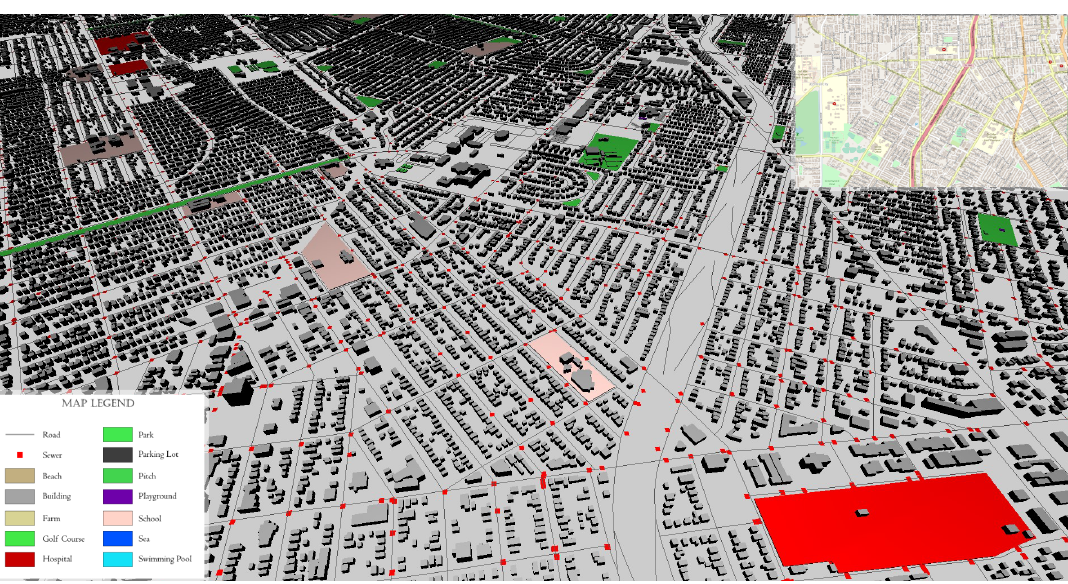
Figure 10. Storm sewer information loaded in the City